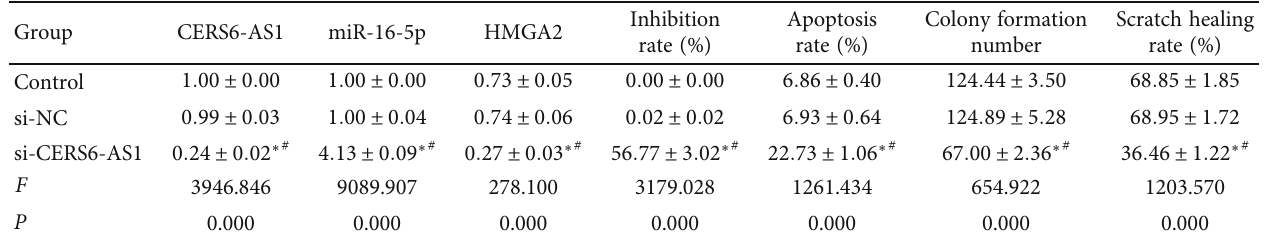
Table 1: E ff ects of silencing CERS6-AS1 on proliferation, migration, and apoptosis of DU145 ( (cid:1) x ± s , n = 9 ).